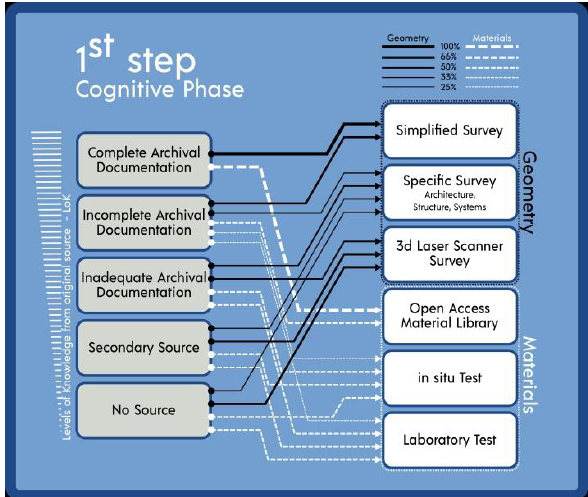
Figure 2: The 1 st step with the definition of the LoK (Level of Knowledge) and the following choice of the suitable